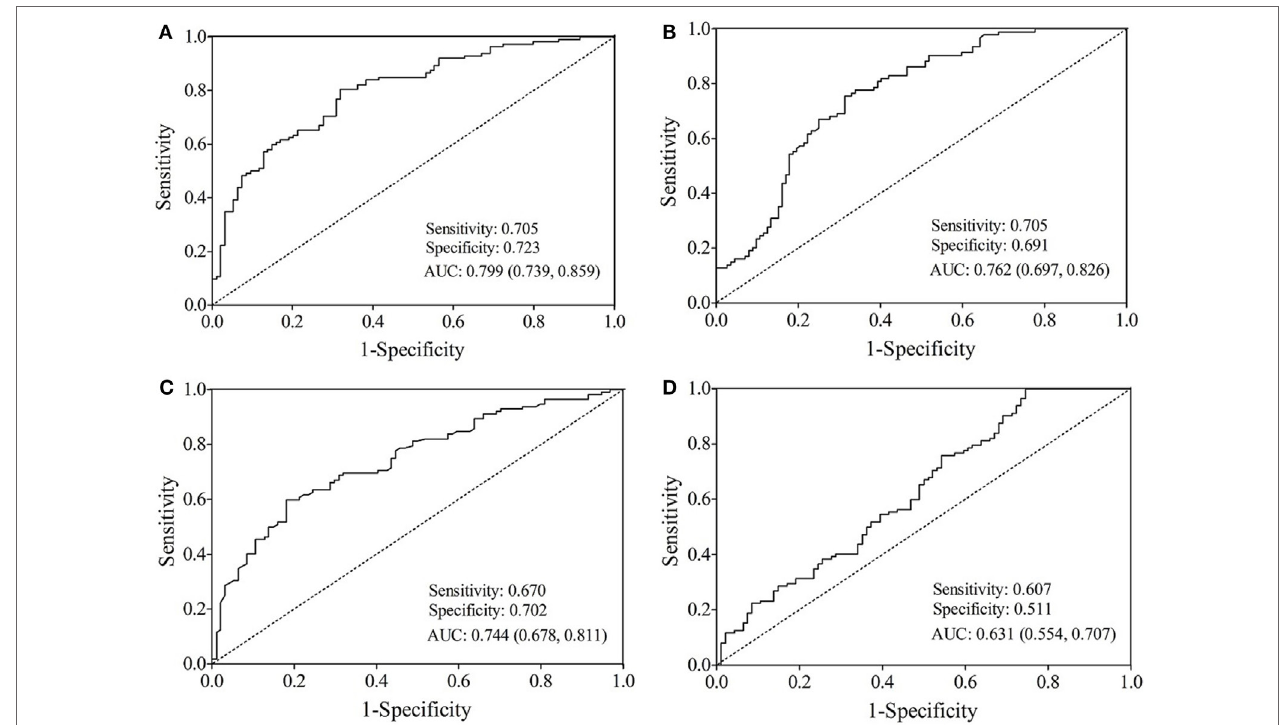
FigUre 3 | Receiver operating characteristic curve analysis for type 2 diabetes mellitus prediction. Area under the curve (AUC) estimation for the microRNAs: (a) let-7b, (B) miR-142, (c) miR-144, and (D)